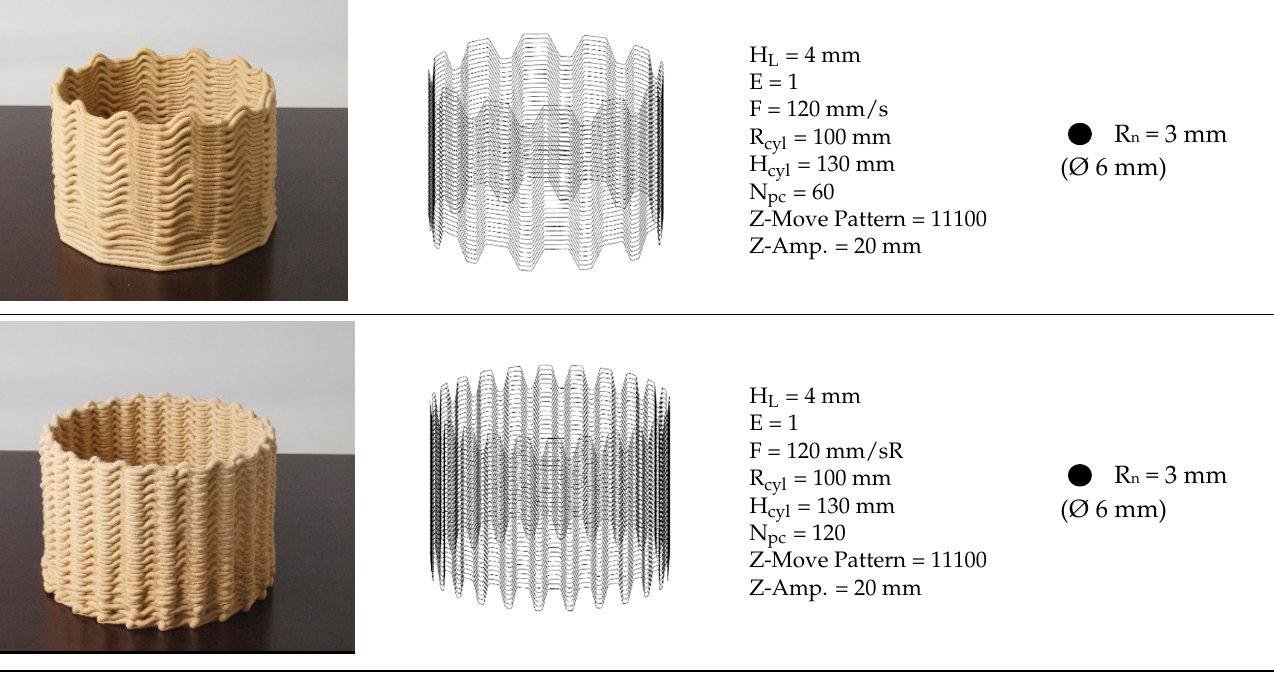
Table 1. Comparison of Grasshopper modelling during path instruction and materialized implementation in the LDM of clay with machine and software parameters.